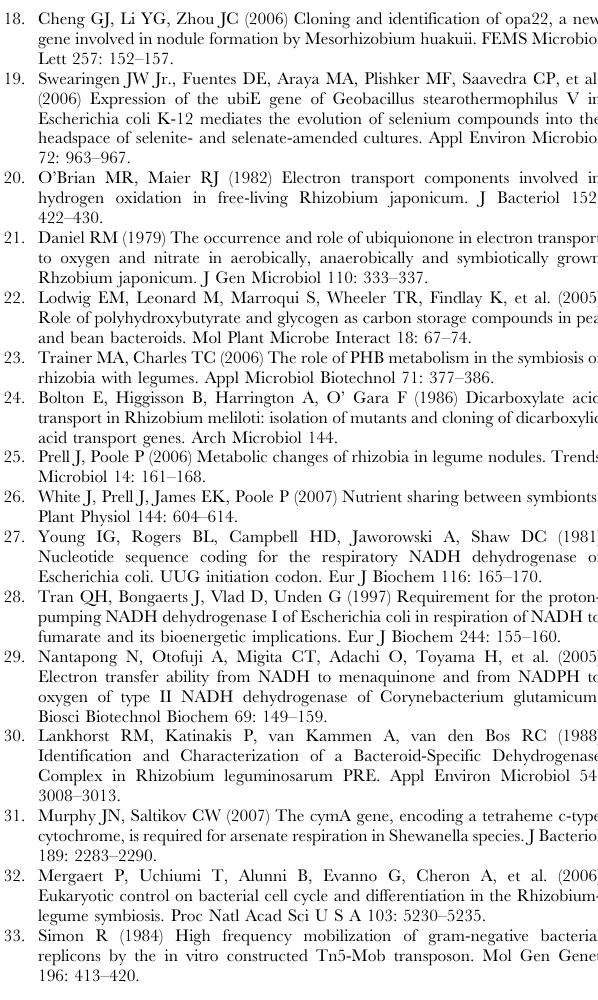
Figure S4 HPLC of the pure standard MK-4, MK-7, MK- 9 and UQ-10. (TIF) Figure S5 Mass spectrum of quinine compounds from E.coli JC7623 D 4-1 and the reacting system of testing DmtH peotein activity. (A) Mass spectrum of DMK-8 which was accumulated in E.coli JC7623 D 4-1 but no MK-8 9 MS found. (B) Mass spectrum of MK-8 which was tested from in reaction system. The result showed MK-8 was synthesized in the reaction system and DmtH had the the function of methyltransferase.